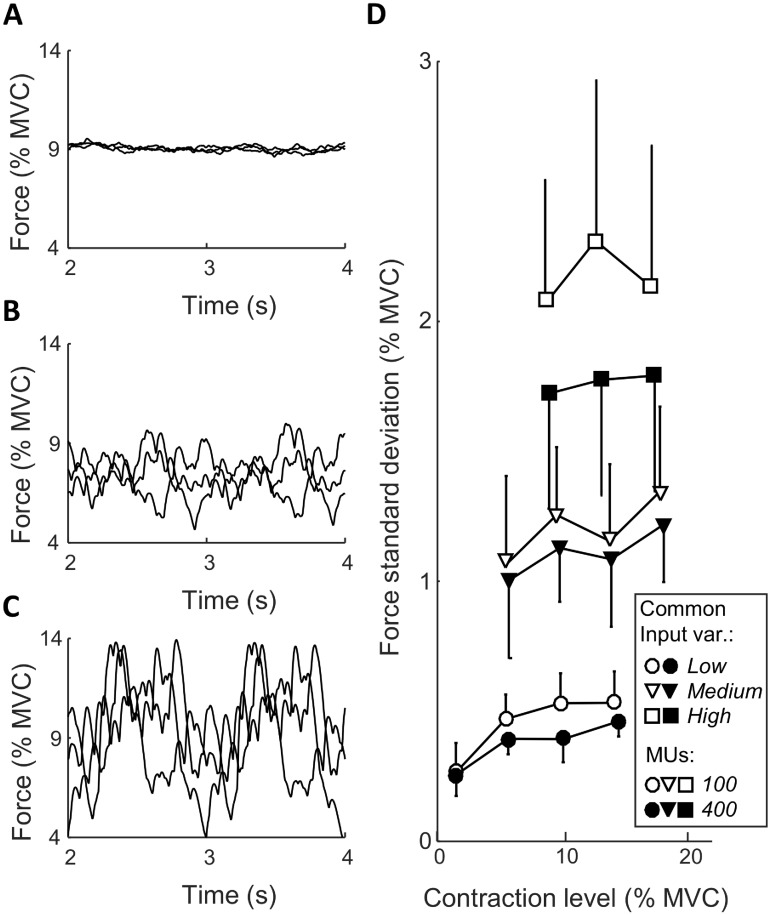
Three representative examples of simulated forces with low (A), medium (B), and high (C) amplitudes of the variability of the common synaptic input to a population of 400 motor neurons.Panel D illustrates the force standard deviation (mean±std) for all simulated conditions. Here, the symbols along each line represent different offsets of the common synaptic input and the different lines represent different amplitudes of common input variability and/or different number of motor units.